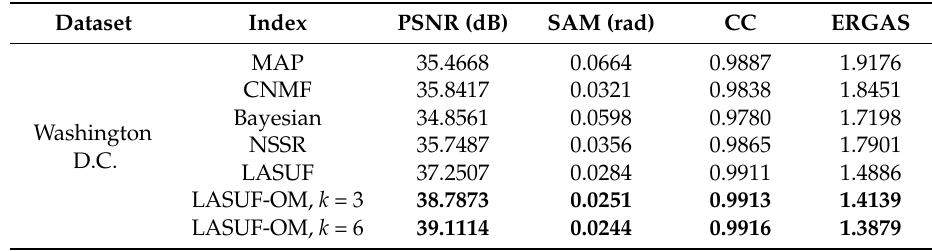
Table 4. Comparison of average statistical indexes of different methods of Washington D.C. (1/3 Subpixel Shift).